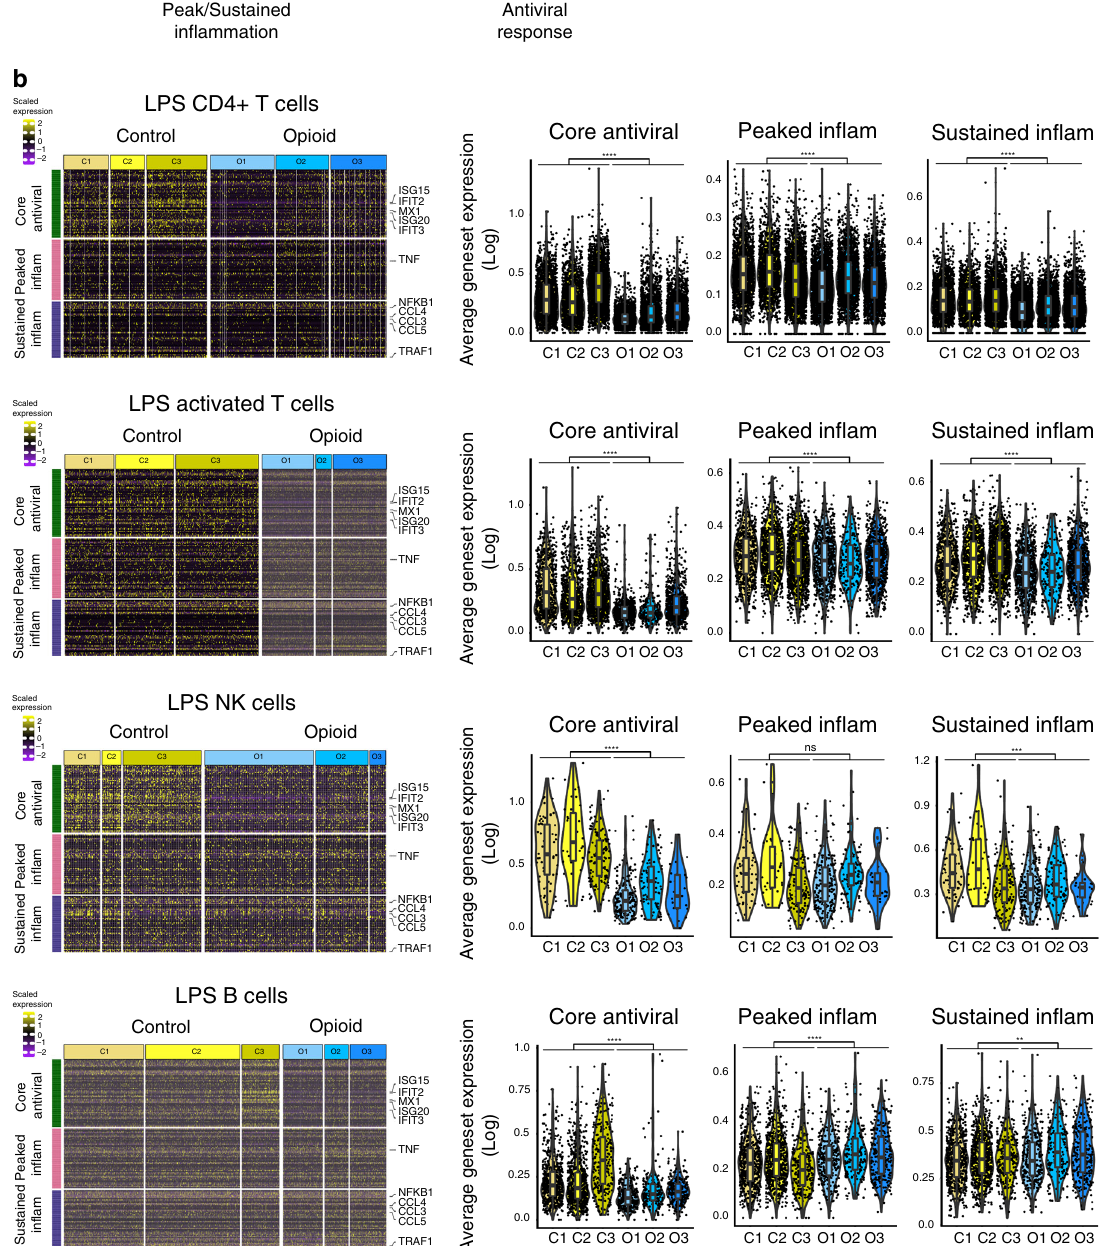
Fig. 1 scRNA-seq revealed a widespread suppression of antiviral genes in opioid-dependent individuals. a Experimental work fl ow schematic. Peripheral blood from opioid-dependent individuals and control individuals were collected, PBMCs were isolated, and microdroplet-based scRNA-seq was performed using Chromium Controller (10X Genomics). b t-SNE plot of naive (51,041) and LPS (100ng/mL)-treated (21,873) PBMCs were clustered (cells were fi ltered based on >300 and <2000 genes per cell, <10,000 UMIs per cell; see Methods) and identi fi ed into immune populations (top) and visualized by control individuals and opioid-dependent individuals in each state (bottom): naive state control samples 1 – 7 (C1 – C7), naive state opioid-dependent samples 1 – 7 (O1 – O7), LPS- treated control samples 1 – 3 (C1 – C3 (LPS)), LPS-treated opioid-dependent samples 1 – 3 (O1 – O3 (LPS)). c Volcano plot showing fold change of gene expression (log2 scale) for downregulated (Control) and upregulated (Opioid) genes for opioid-dependent cells compared to non-dependent controls for naive state populations: monocytes and LPS-treated populations: NK cells, CD4 + T cells, and activated T cells ( x -axis) with a signi fi cance of 0.05 ( y -axis, − log10 scale). Signi fi cant genes shown with black dots, signi fi cant antiviral genes shown with green dots, and insigni fi cant genes shown with gray dots. d Pathway enrichment analysis of signi fi cant differential genes across all naive and LPS-treated cell types evaluated by − log10( p value) as indicated by blue-purple scale ( x -axis: cell type/state, y -axis: pathways). White represents an analysis which did not provide enrichment results for the speci fi c pathway. Source data listing genes and expression values for c and d are provided in Source Data fi le. Similar fi ndings were observed in repeat experiments using different patient